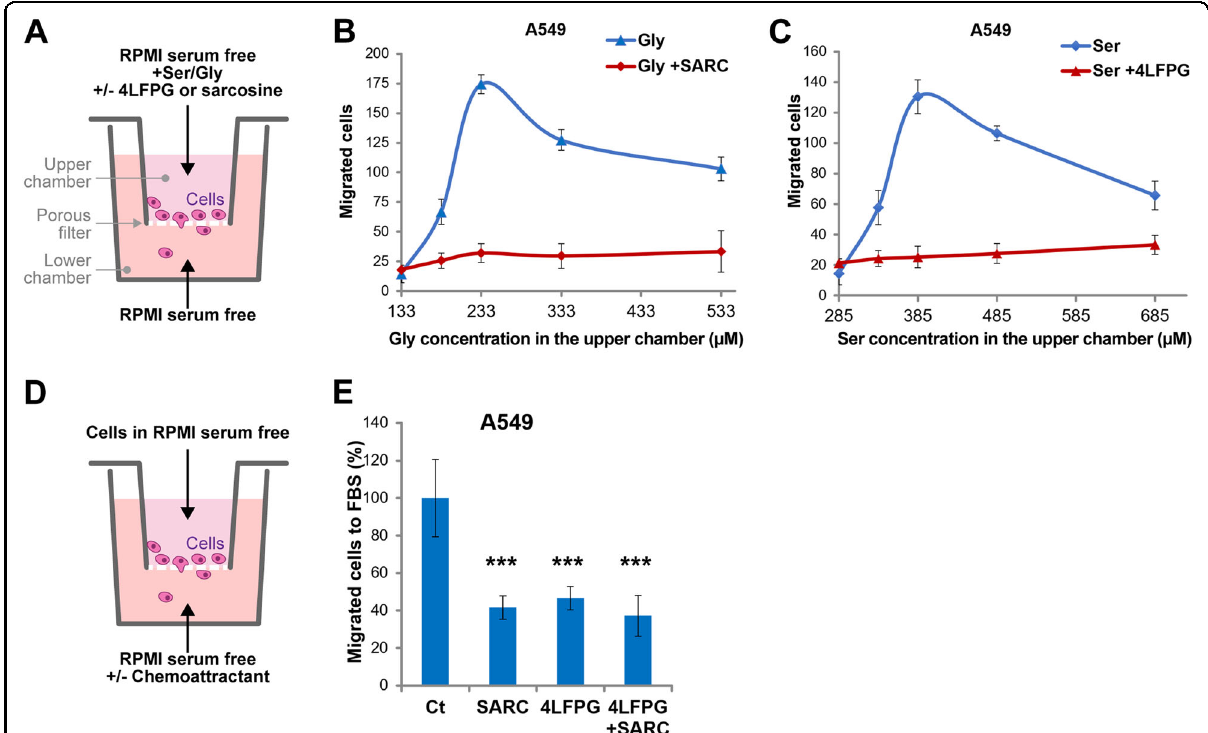
Fig. 1 Serine and glycine intracellular levels affect the migratory properties of lung adenocarcinoma cells. A Scheme of competitive cell migration test using the Boyden chamber. The cells were resuspended in RPMI serum free (that initially contains 285 μ M serine (Ser) and 133 μ M glycine (Gly)) and seeded in the upper chamber, supplemented with increasing concentrations of Ser or Gly (0, 50, 100, 200, and 400 μ M) in presence or not of 25 μ M of 4LFPG or SARC, respectively. The migrated cells were then counted and represented as a function of amino acid concentration in ( B ) for Gly and in ( C ) for Ser ( n = 3 each). D Schematic representation of chemoattraction bioassay test using Boyden chamber. The cells were placed in RPMI serum free in the upper chamber, while the lower chamber was fi lled with RPMI serum free plus chemoattractant 50% FBS or 100% BEF. Migration test of A549 cells to 50% FBS, pretreated or not for 3 h with SARC and/or 4LFPG. The migrated cells were then counted and represented in ( E ) ( n =